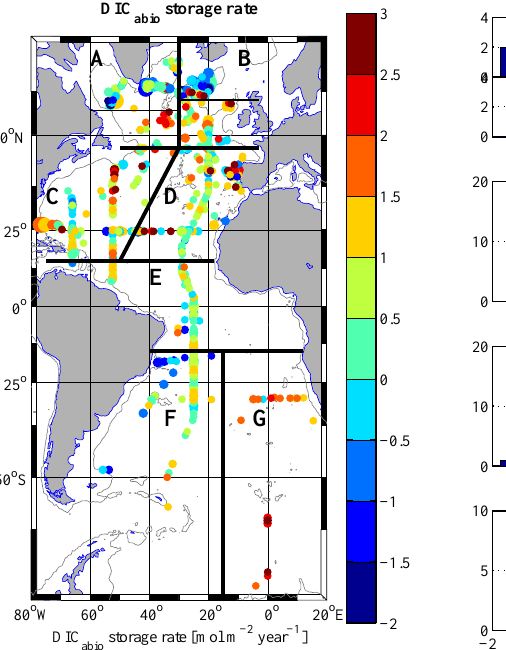
Fig. 3. Same as Fig. 2 but for storage rates (molm − 2 yr − 1 ) of DIC abio .